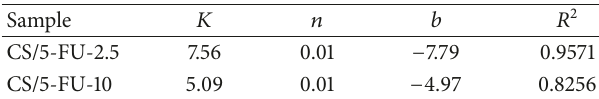
Table 4: Parameters of regression of Korsmeyer on the liberation 5-FU in PBS of pH